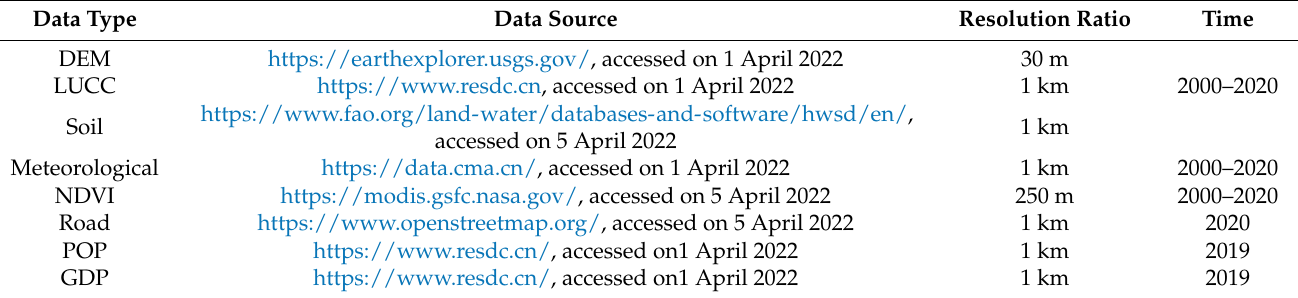
Table 1. List of datasets and their original